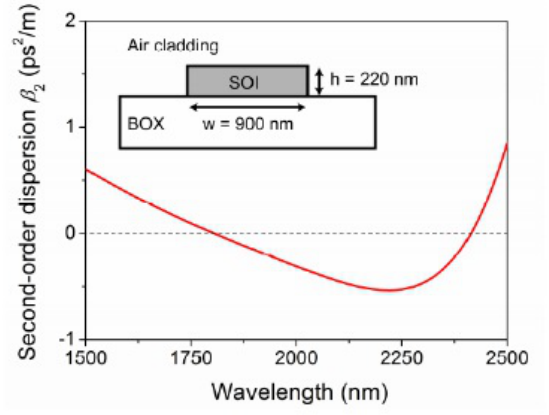
Fig. 12. The group velocity dispersion of the waveguide used for the mid-infrared parametric amplifier experiment as well as for the OPO experiment discussed in Section 3.3. The inset shows a cross- section of the waveguide. Adapted from reference [57].